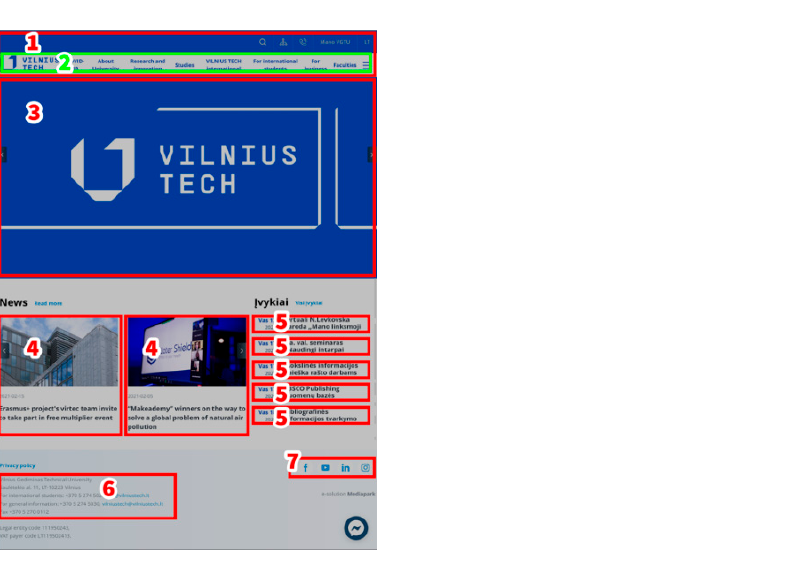
Figure 1. Website content segmentation example.